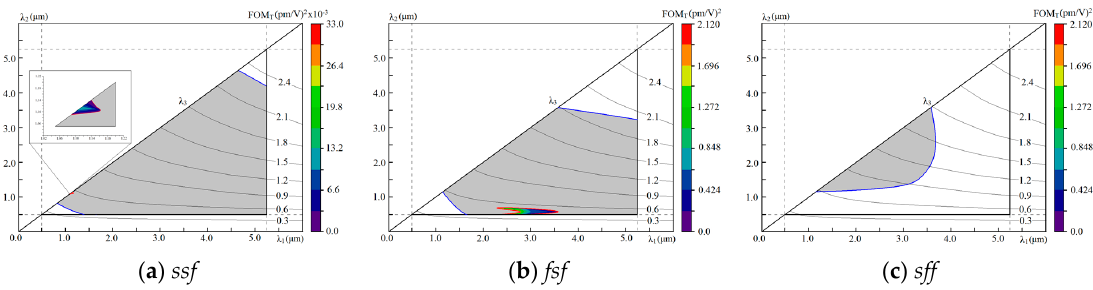
Figure 15. FOMT ( λ 1 , λ 2 ) distribution for RTA crystal for all types of interactions: ( a ) ssf , ( b ) fsf , ( c ) sff.